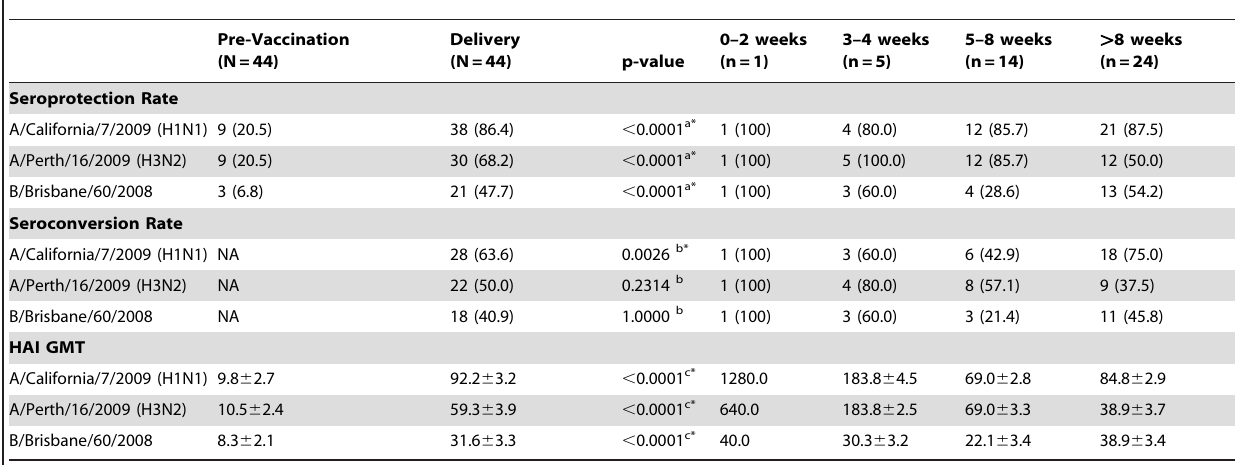
Table 3. Seroprotection rate, seroconversion rate, and HAI GMT of 44 subjects at delivery.